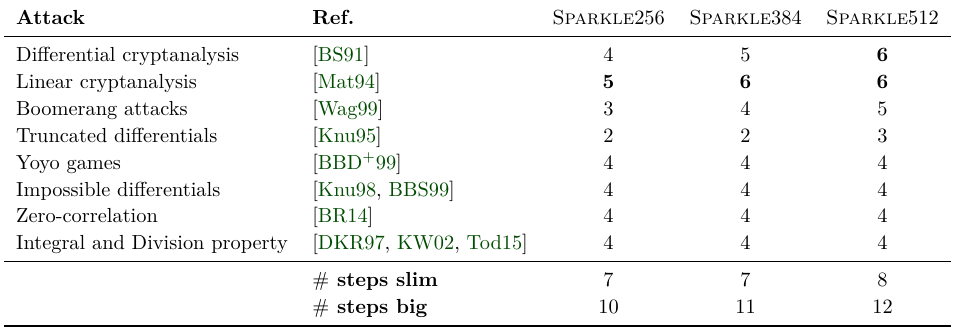
Table 5: This table lists upper bounds on the number of steps for which we found an attack, or for which the differential and linear bounds are too low to guarantee security, breaking a security level of 𝑏 bits, where 𝑏 denotes the block size, with regard to several 2 attack vectors. The numbers for differential and linear attacks correspond to the bounds given in Table 6 and Table